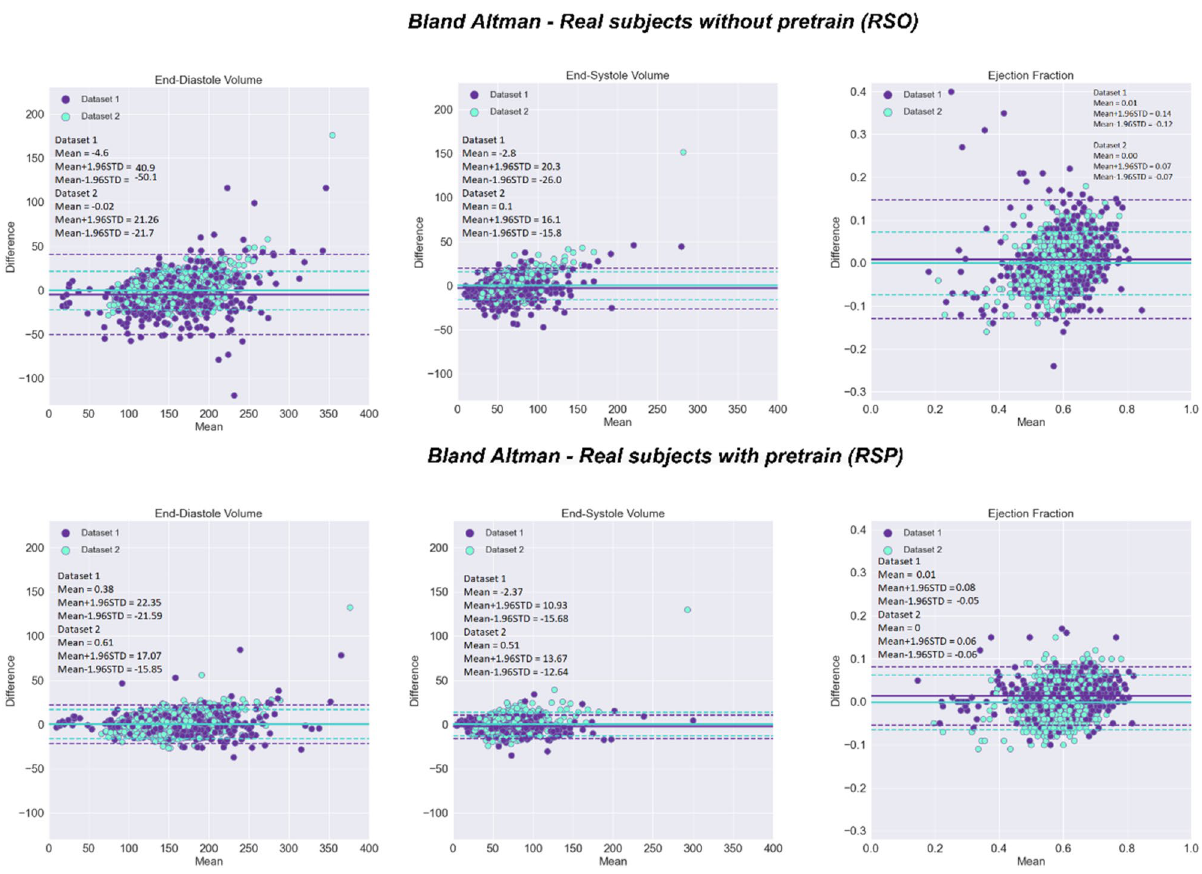
Figure 5. Bland–Altman (BA) plots of predicted and ground truth volumes and EF on the Dataset 1 test dataset (purple) and Dataset 2 test dataset (light blue), for the model trained on real cases only, without pretraining (RSO) and the model finetuned on real cases after pretraining on synthetic data (RSP). Bland–Altman (BA) analysis of the results, comparing the models trained on real cases without pretraining (top) and real cases with finetuning from the synthetic model (bottom).